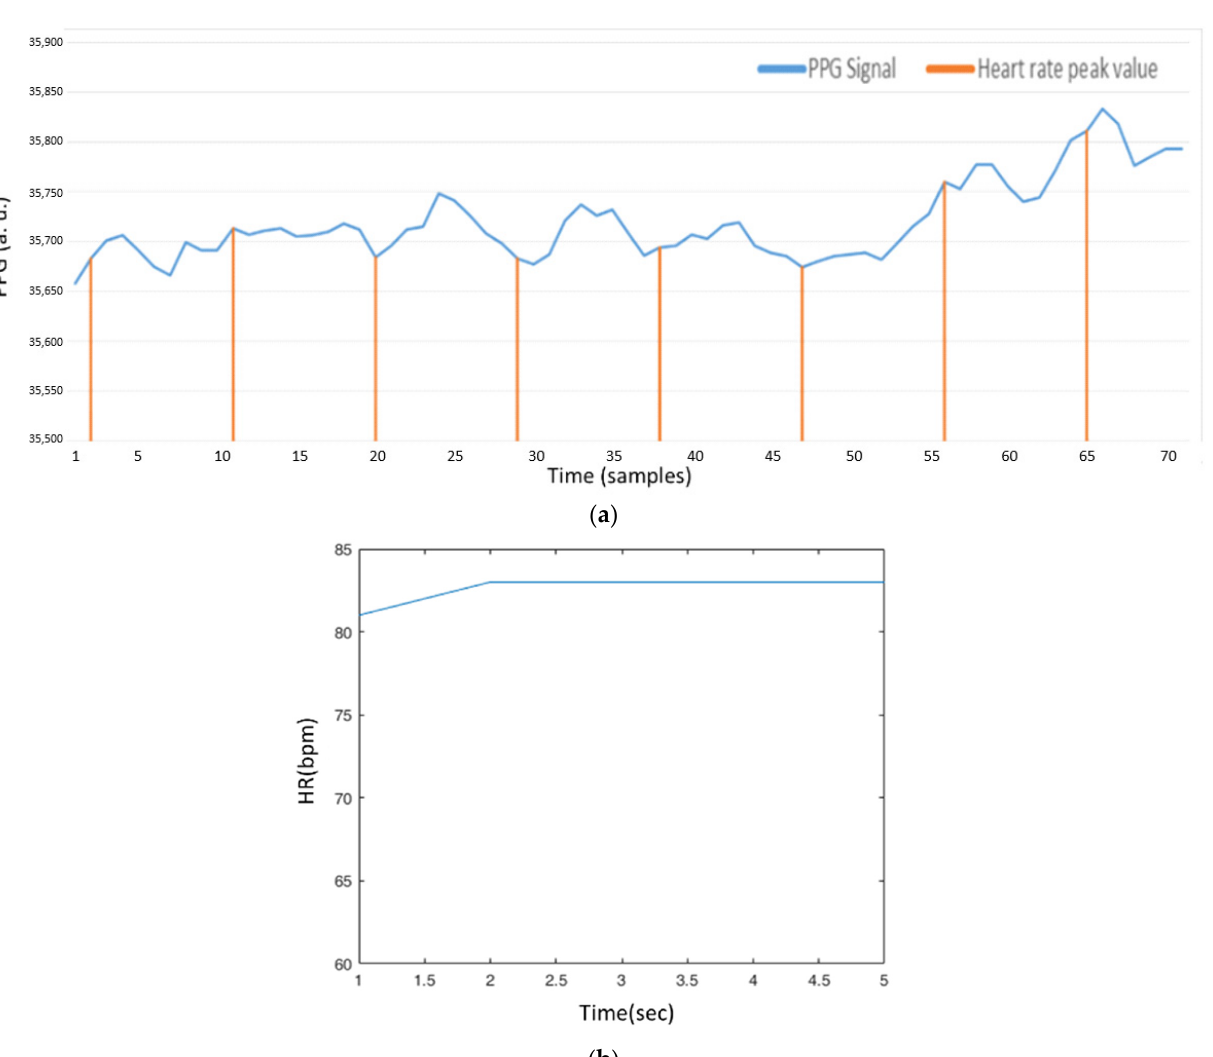
Figure 22. ( a ) AMPD algorithm based on Laplacian (AMPD Threshold = 2/𝐿 , L = 7); ( b ) Heart rate signal (AMPD Threshold = 2/𝐿 , L = 7).